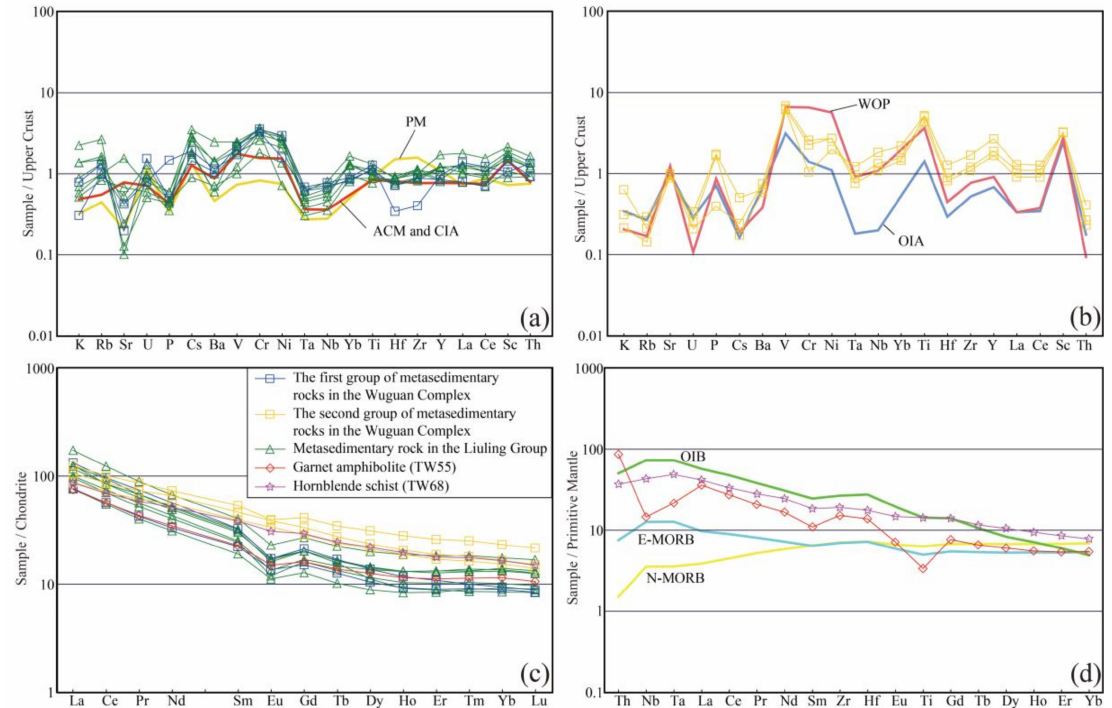
Figure 6. Spider diagrams and REE patterns of metamorphosed clastic and meta-igneous rocks from the Wuguan Complex and Liuling Group. ( a , b ) Normalized to average upper crustal values (after [61,62]). ( c ) Chondrite-normalized REE patterns of metamorphosed clastic (after [63]). ( d ) Prim- itive mantle-normalized multi-elemental diagrams of amphibolite from the Wuguan Complex (after